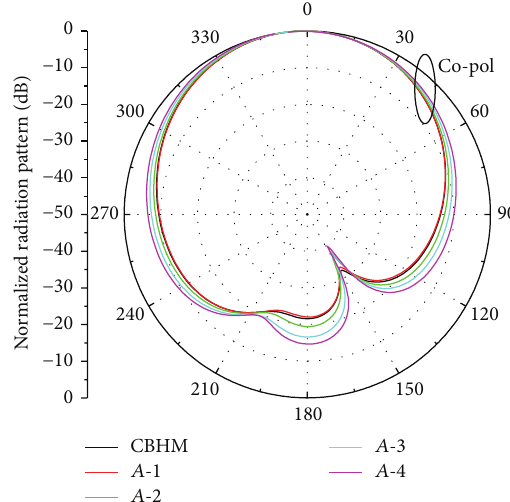
Figure 11: Input impedance of the SIW antenna.